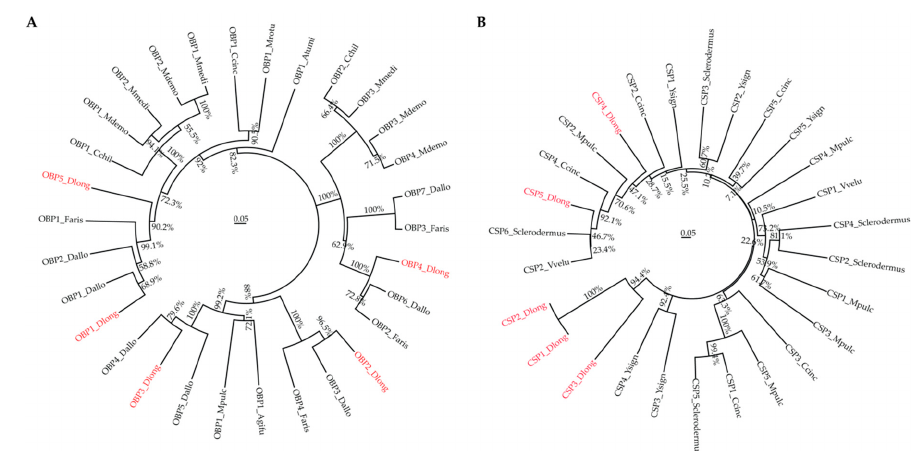
Figure 3. Phylogenetic trees for OBPs ( A ) and CSPs ( B ). Ashmead proteins are highlighted in red, the percentage represents the bootstrap value, and the scale bar represents the evolutionary distance.